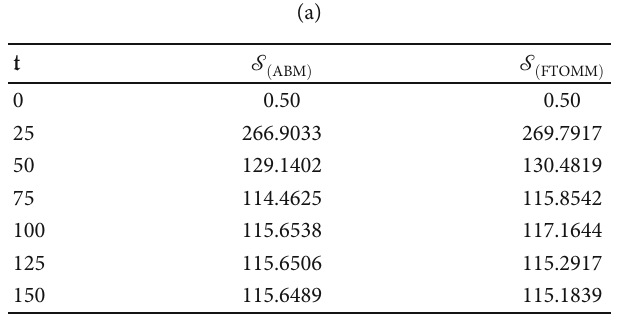
Table 1: Compared approximate results of four state functions obtained by ABM and FTOMM. (a) S , (b) P